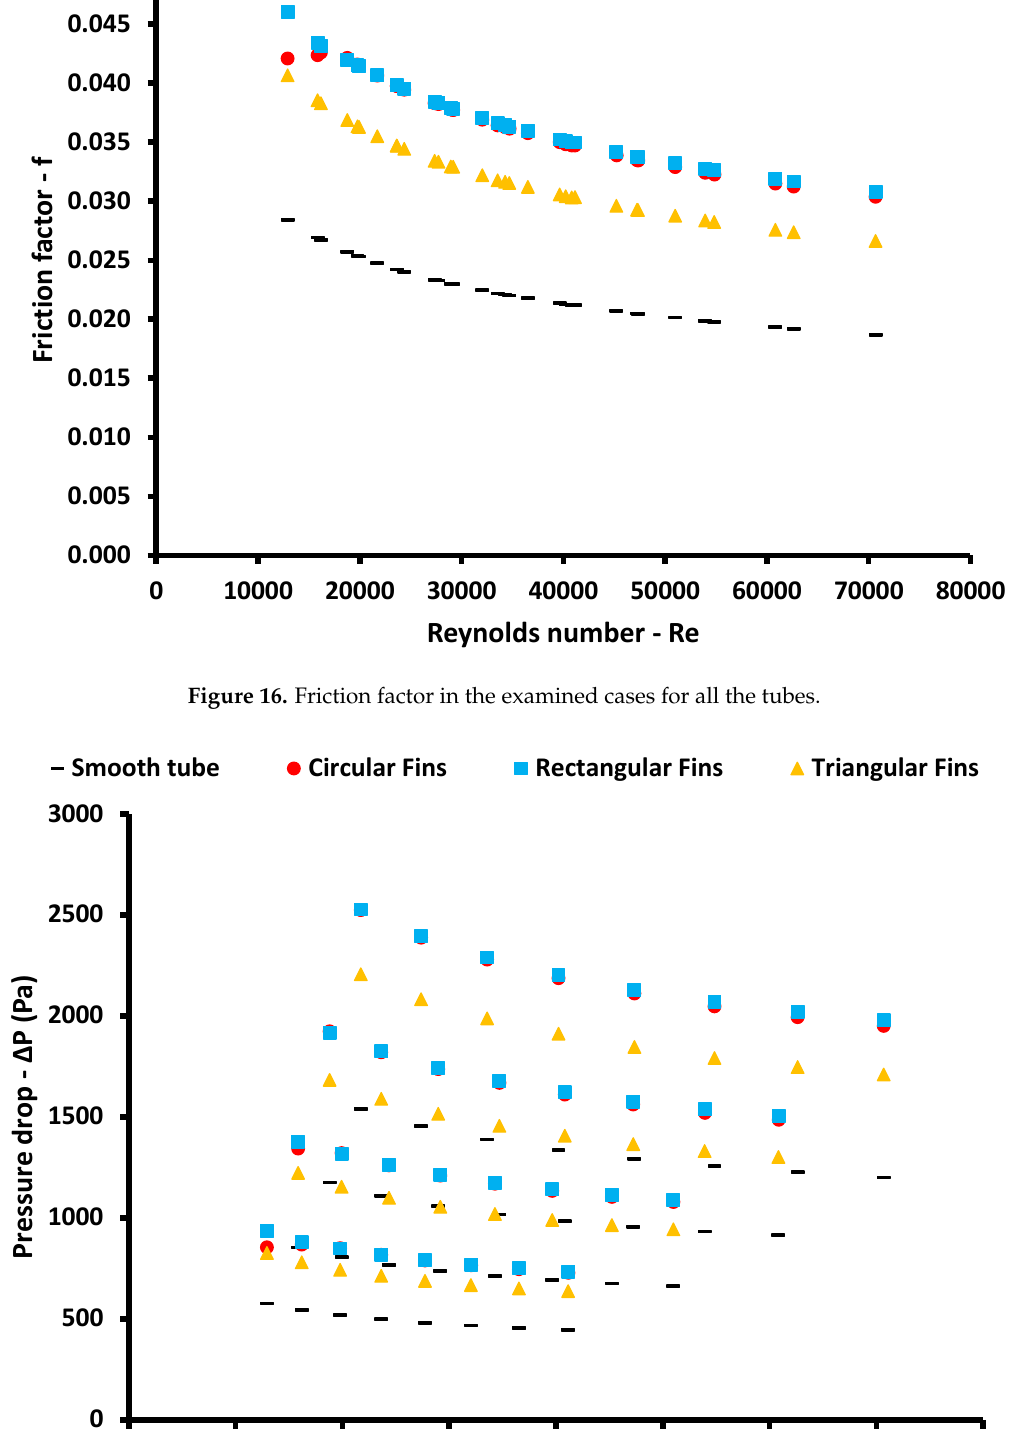
Figure 17. Pressure drop in the examined cases for all the tubes.